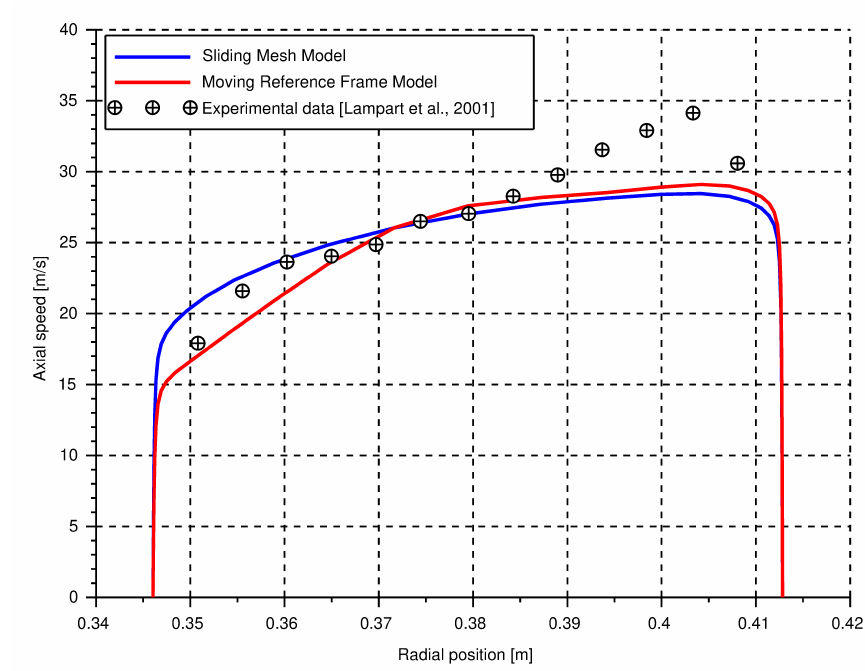
Figure 7. Comparison of computed and experimental radial distribution of axial speed at 135% of the axial chord downstream of the rotor trailing edge.